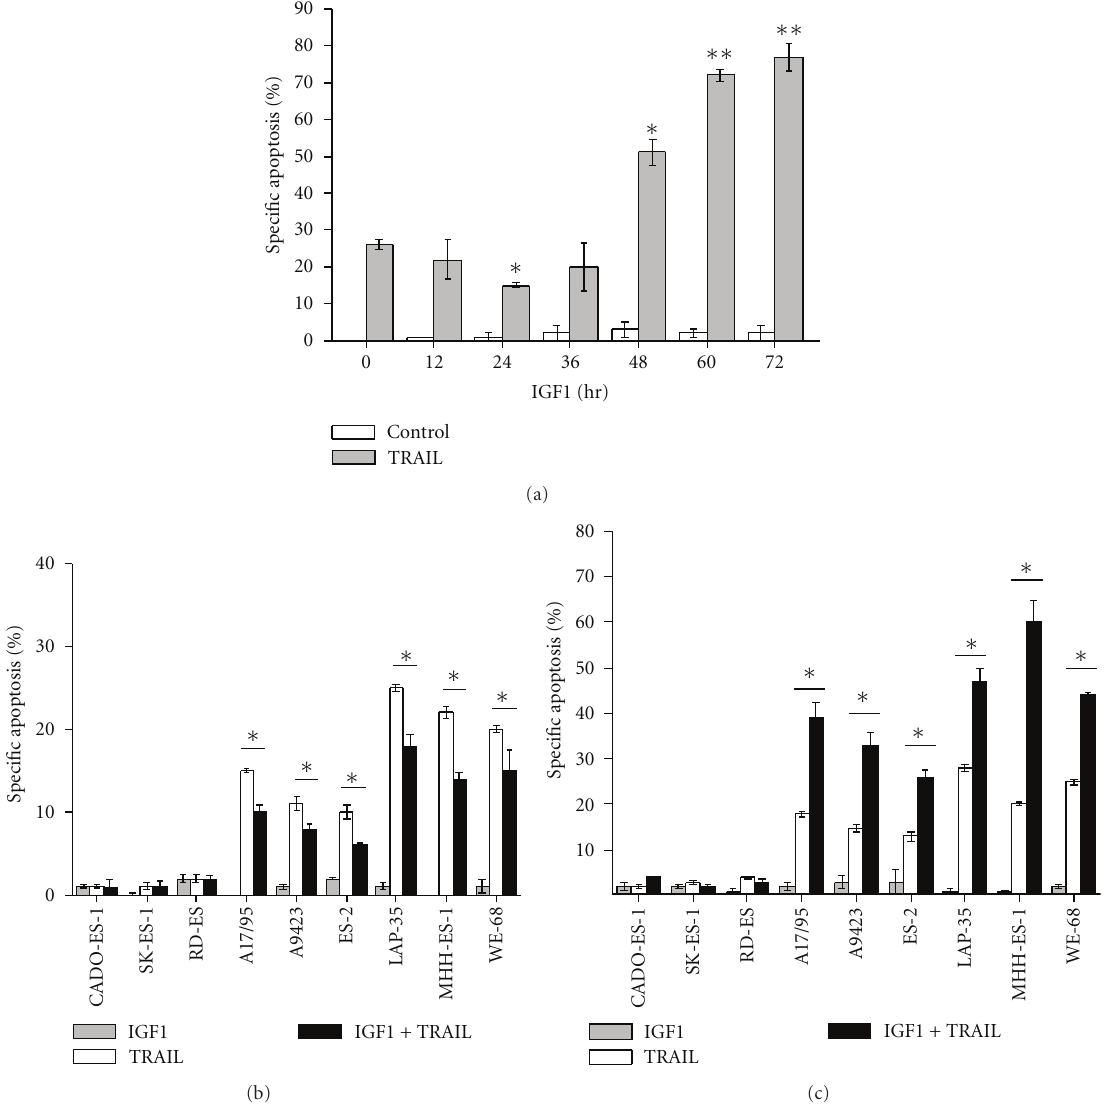
Figure 1: Time-dependency of IGF1 on Apo2L/TRAIL-induced apoptosis. (a) Percentage-specific apoptosis in VH-64 cells treated for the times indicated with IGF1 (50ng/mL), followed by incubation with Apo2L/TRAIL (TRAIL; 50ng/mL; 8 hours) or serum-free medium alone (Control). Percentage-specific apoptosis in cells from di ff erent ESFT lines treated for (b) 24 hours and (c) 72 hours in the absence and presence of IGF1 (50ng/mL), followed by incubation with Apo2L/TRAIL (TRAIL; 50ng/mL; 8 hours) or serum-free medium alone. Asterisks: ∗ P < 0 . 05; ∗∗ P < 0 . 02; error bars: mean ± SD of triplicate determinations from 3 independent